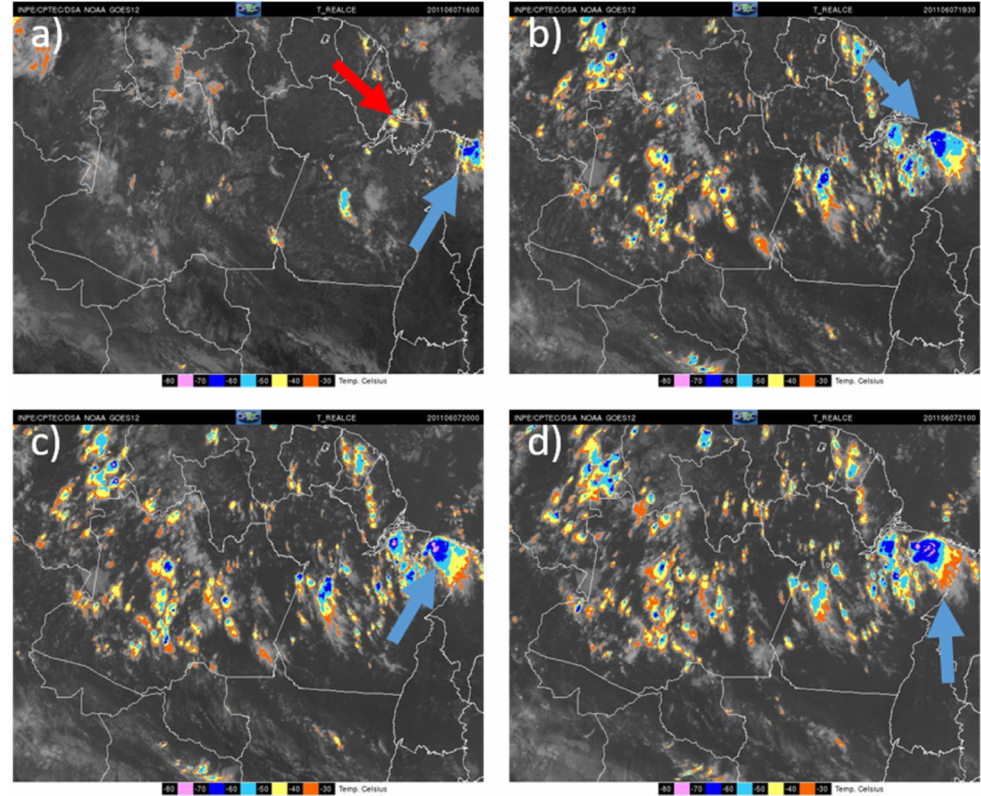
Figure 3. Infrared satellite images from GOES 12 focused on the northern region of Brazil at 1600 UTC ( a ), 1930 UTC ( b ), 2000 UTC ( c ), and 2100 UTC ( d ). The colors represent the cloud top temperature, from − 80 ◦ C (pink) to − 30 ◦ C (orange). The blue arrows indicate the system of interest, and the red indicates where Maraj ó Island is